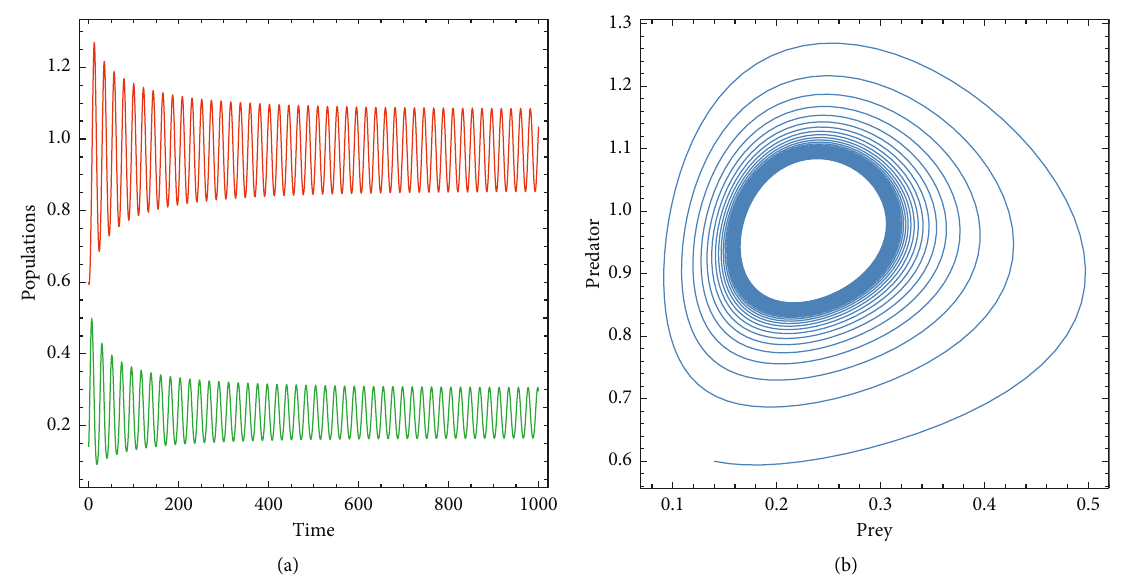
Figure 3: Periodic oscillations. (a) Time plot; (b) phase portrait for the model (51) with m